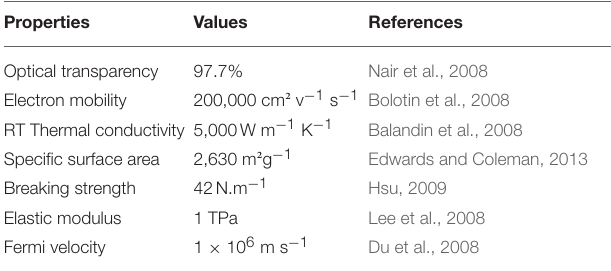
TABLE 1 | The most exceptional properties of single layer